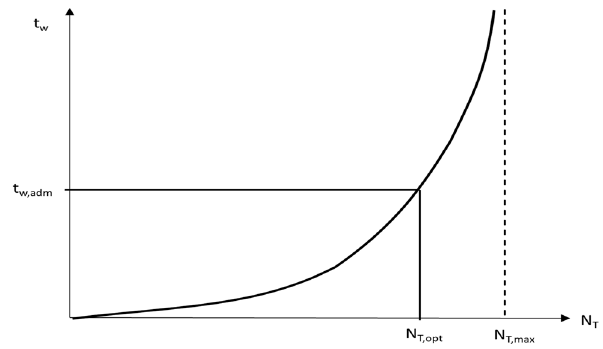
Figure 2. Waiting time function [25].